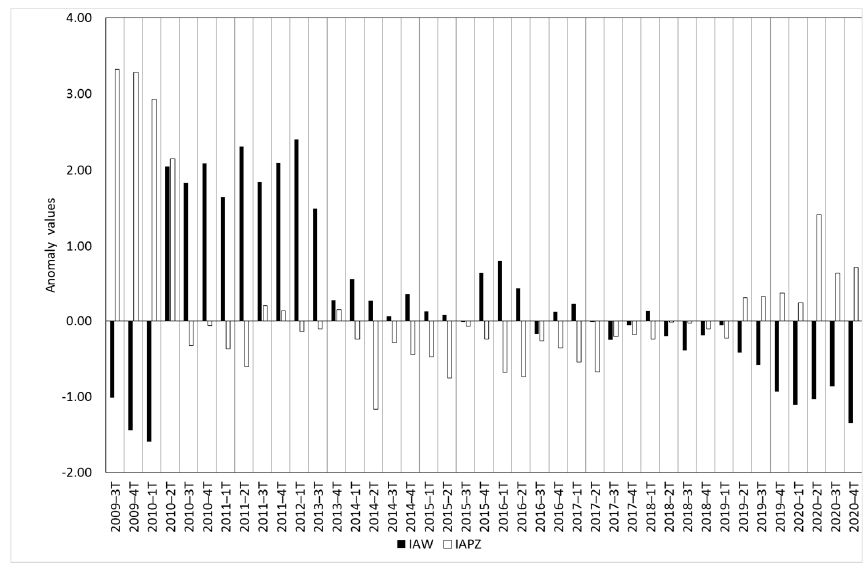
Figure 5. Water surface anomaly index (IAW) and the piezometric anomaly index (IAPZ) in the period 2009–2021.